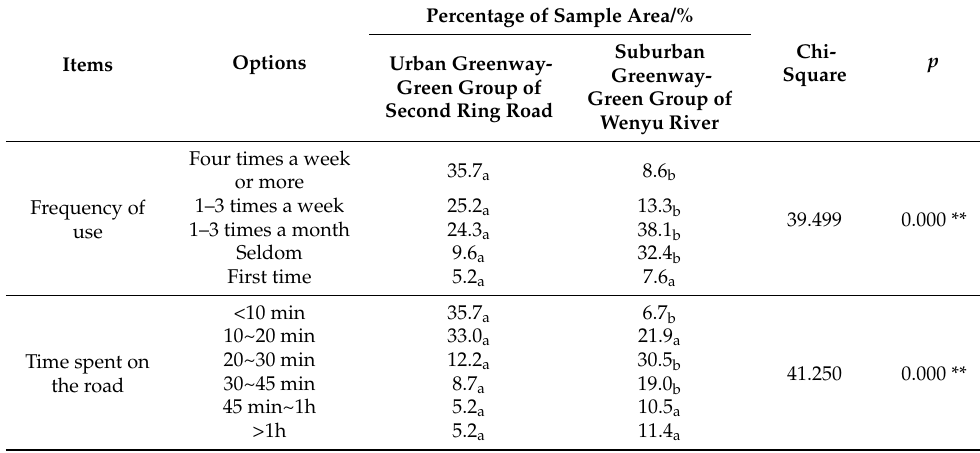
Table 4. Chi-square test for spatio-temporal